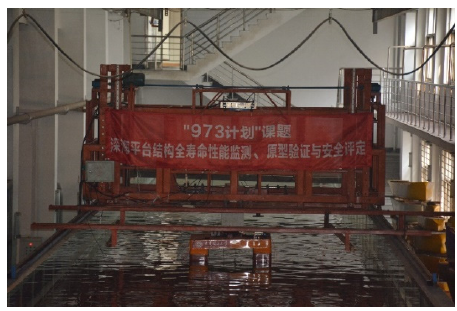
Figure 7. The picture of the scale model in the wave tank.